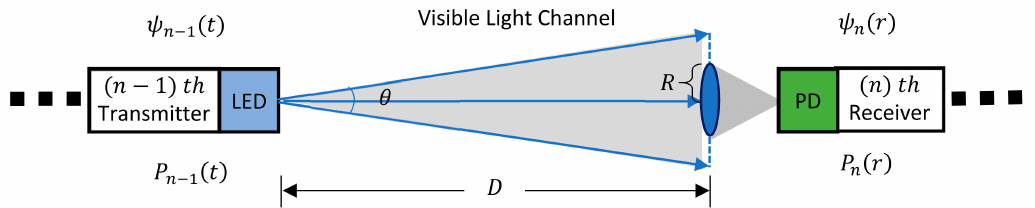
Figure 1. Structure of image transmission channel based on